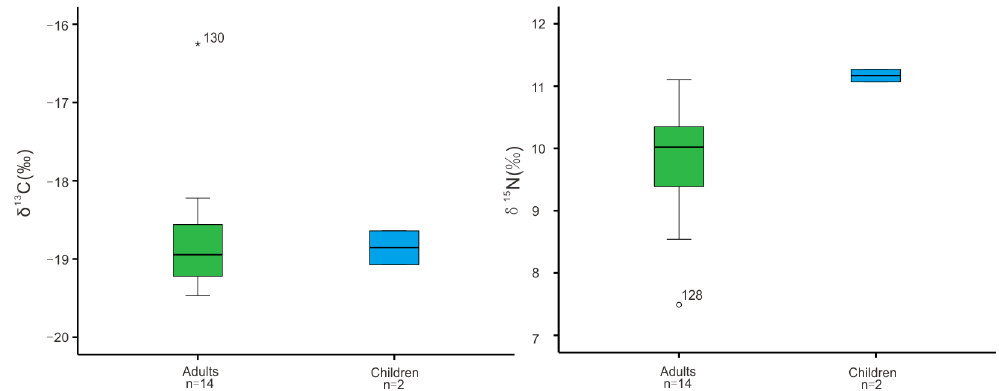
Fig 5. Comparison of human isotopic signatures for adult vs. child